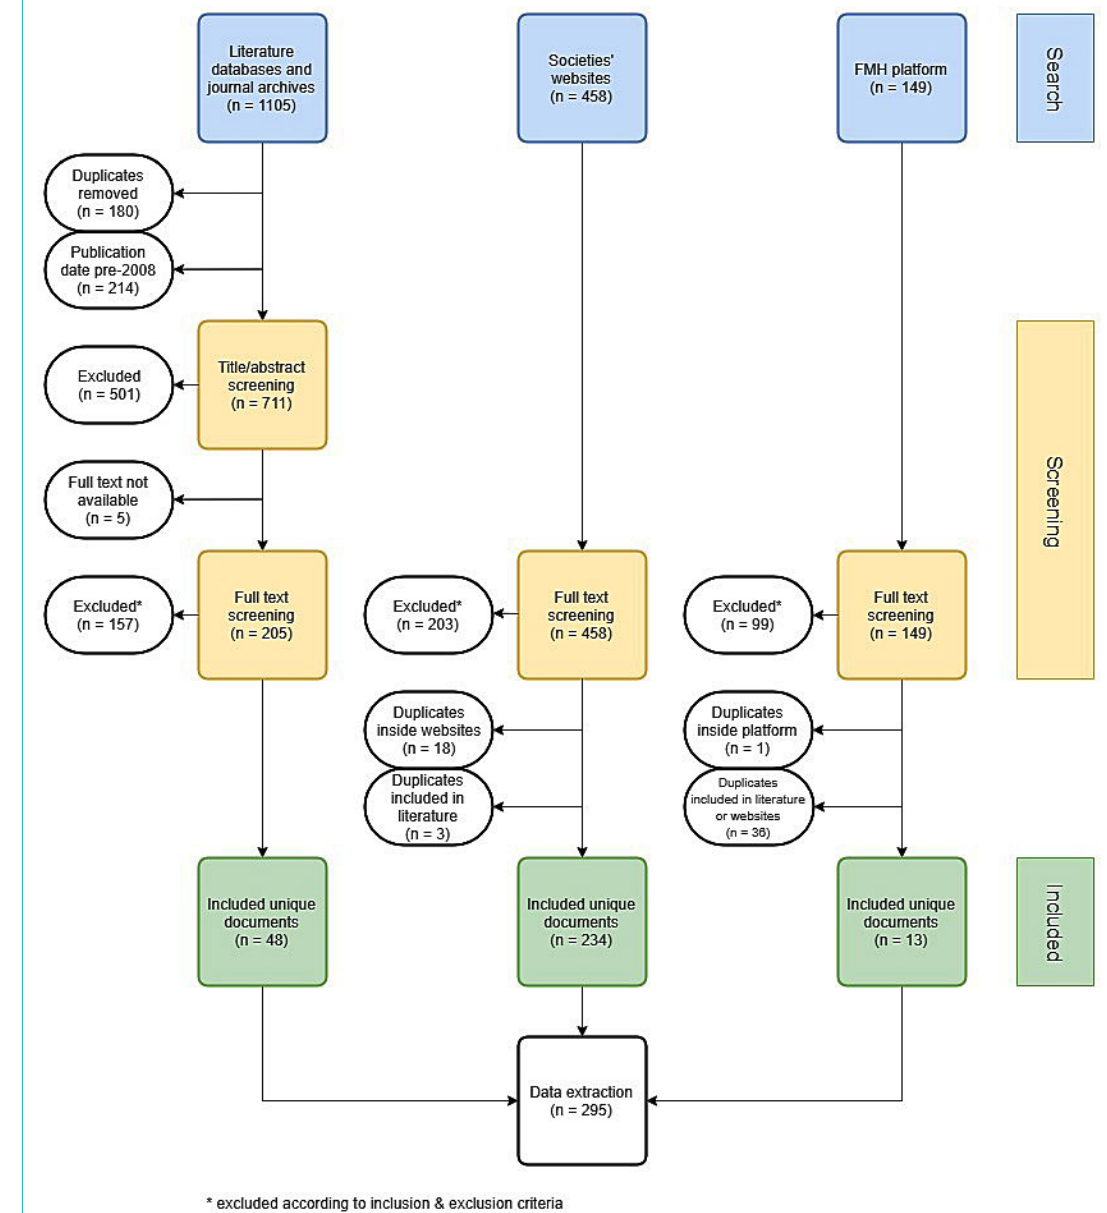
Figure 1: PRISMA flowchart of guideline search, screening and